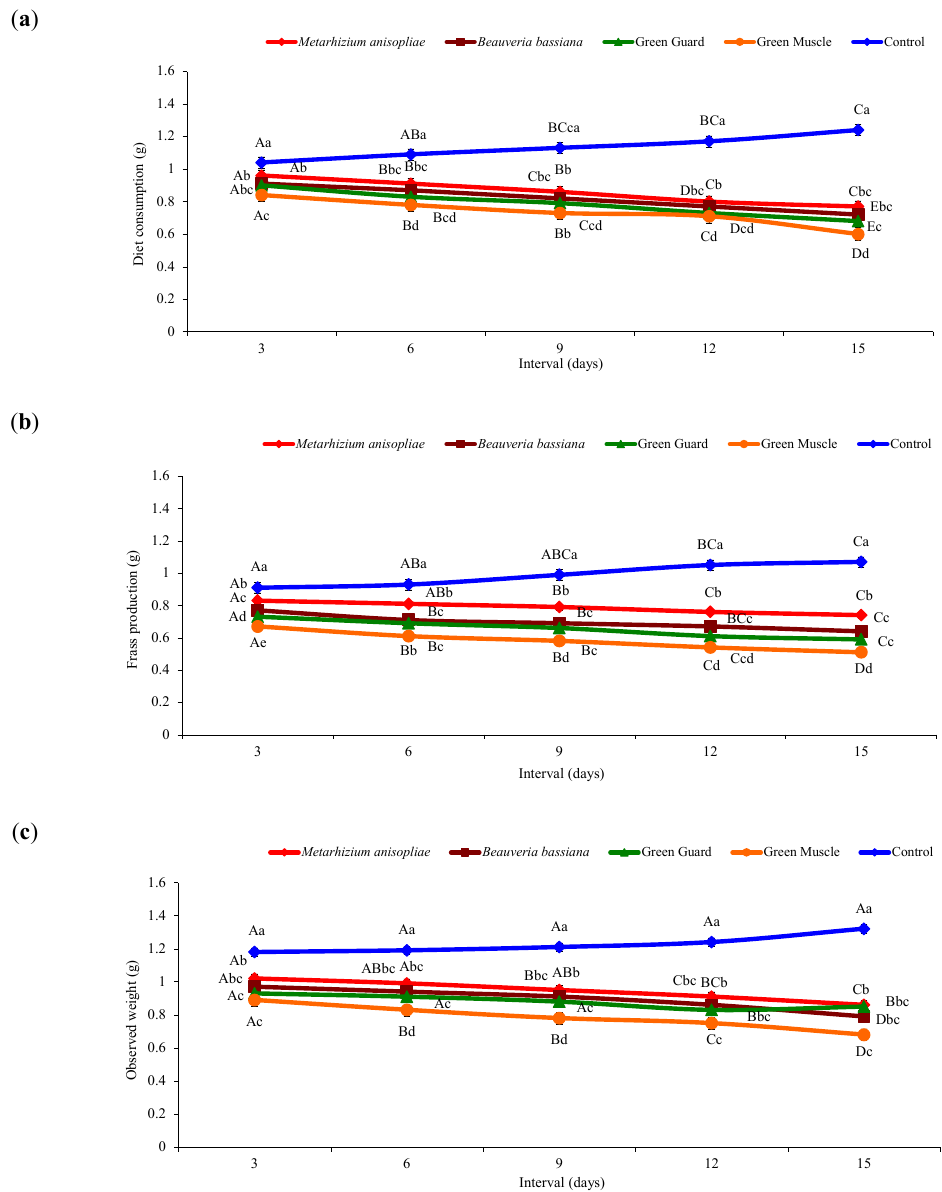
Figure 4. Means ( ± SE) for ( a ) diet consumption, ( b ) frass production, and ( c ) observed weight of fifth-instar S. gregaria treated with a sublethal dose (1 × 10 4 conidia/mL) of Green Muscle, Green Guard, B. bassiana , or M. anisopliae . For each subfigure: different lowercase letters indicate significant differences between different EPF; different uppercase letters indicate significant differences between different days (Tukey’s HSD test at p ≤ 0.05).